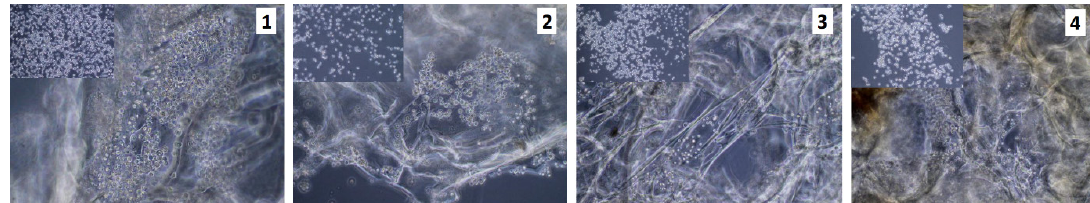
Molecules 2017 , 22 , x FOR PEER REVIEW 9 of 15 Figure 10. Standard cell culture of the HCT116 cells (sample 1—chitosan crosslinked with adipic and malonic acid; sample 2—chitosan crosslinked with adipic and L -glutamic acid; sample 3—chitosan crosslinked with adipic, L -glutamic and malonic acid; sample 4—chitosan crosslinked with adipic and levulinic). The VK2/E6E7 cells did not flatten and did not proliferate. Such results suggest that certain ingredients in the media negatively affected the cell’s growth (Figures 11–16). The cells also did not grow at the bottom of the well, where there was no scaffold present (small photo set in large photographs).